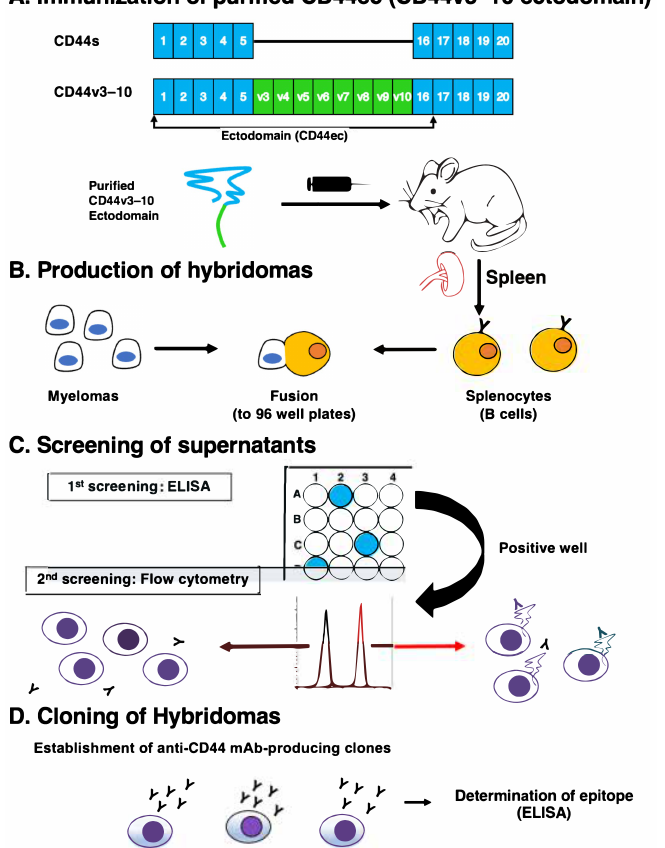
Figure 1. A schematic illustration of anti-human CD44 mAb production. ( A ) Purified CD44v3–10 ectodomain was intraperitoneally injected into BALB/c mouse. ( B ) Hybridomas were produced by fusion of the splenocytes and P3U1 cells. ( C ) The screening was performed by enzyme-linked immunosorbent assay (ELISA) and flow cytometry using parental CHO-K1 and CHO/CD44v3– 10cells. ( D ) After cloning and additional screening, a clone C 44 Mab-34 (IgG 1 , kappa) was established. Furthermore, the binding epitopes were determined by ELISA using peptides, which cover the extracellular domain of